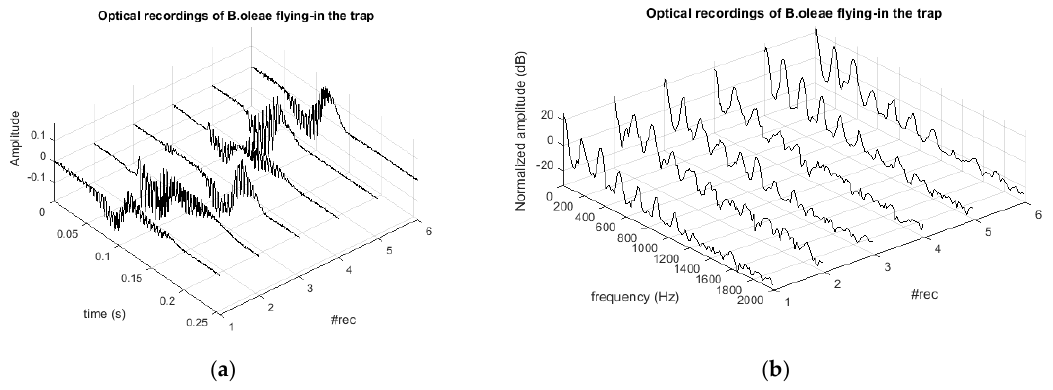
Figure 5. ( a ) Optical recording of different cases of B. oleae flying in the trap. High-frequency modulation due to wingbeat and low-frequency main-body movement; ( b ) spectra of the corresponding recordings. The fundamental frequency is at around 200 Hz and at least five harmonics are resolved.